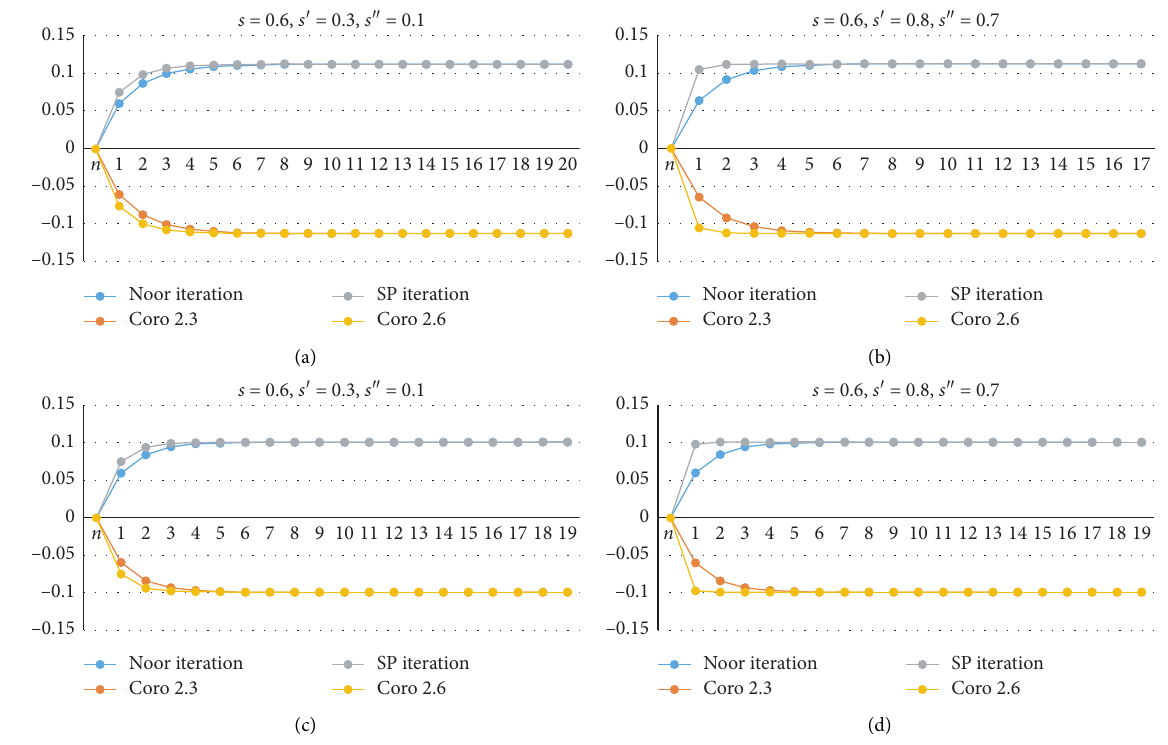
Figure 1: (a, b) Graphs of quadratic functions in Tables 1 and 2, respectively. (c, d) Graphs of cubic functions in Tables 3 and 4, respectively.